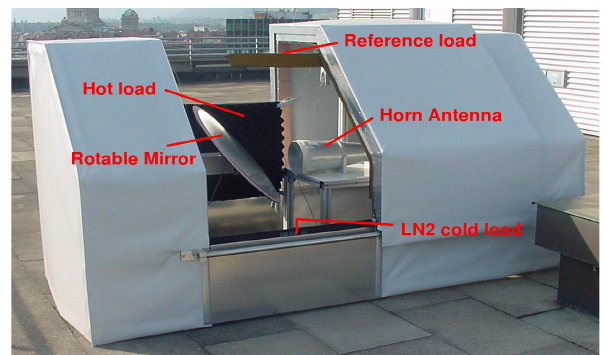
Fig. 2. The MIAWARA-instrument on the roof of the ExWi- building: the front-end of the instrument basically consists of a ro- tatable mirror, which reflects the radiation into the horn antenna. A reference absorber is mounted next to the mirror as hot load for the tipping calibration, and a reference absorber bar is attached on top of the instrument for the balancing calibration. Further, a pan for the liquid nitrogen is included.